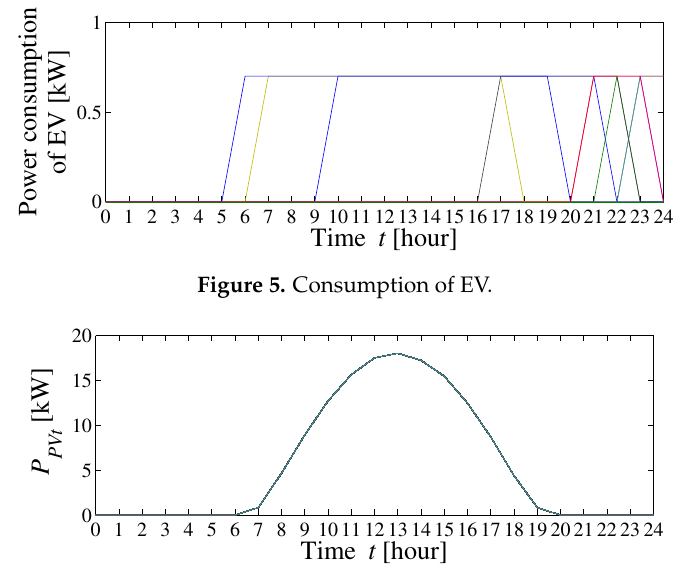
Figure 6. PV output